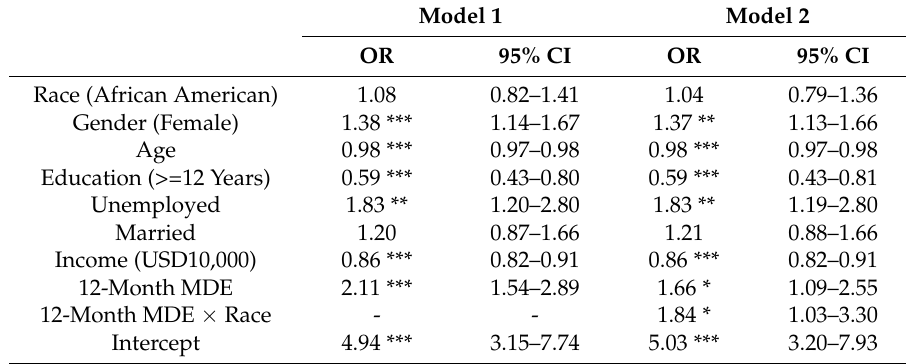
Table 2. Summary of logistic regressions with major depressive episode (MDE) as the independent variable and financial distress as the dependent